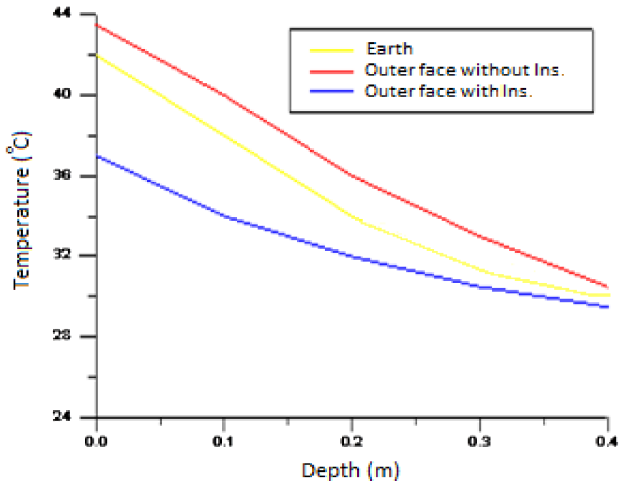
Fig. 7. Effect of insulation on the foundation (06 August (cid:3) 10